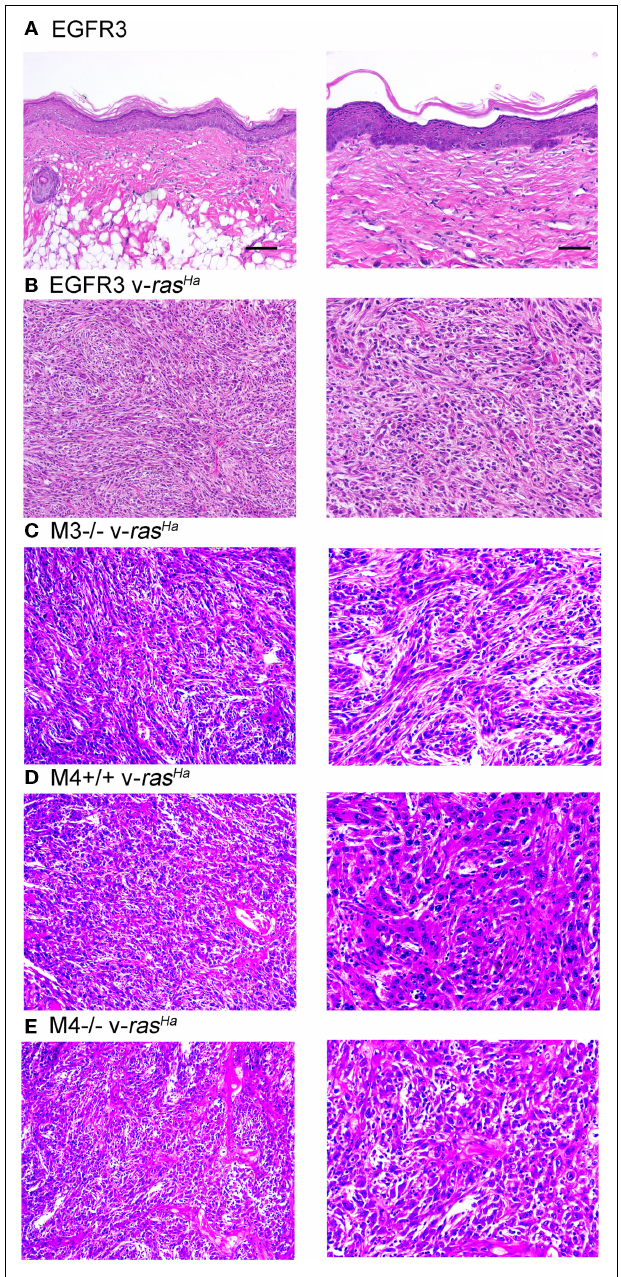
FIGURE 6 | Non-transformed immortalized keratinocytes produce epidermis in orthotopic skin grafts or squamous cell carcinoma following introduction of a v- ras Ha oncogene . Immortalized EGFR3 line keratinocytes from an Egfr fl/fl mouse on an FVB/N background ( N = 3) (A) , EGFR3 keratinocytes infected with a v- ras Ha -expressing retrovirus (B) , immortalized M3 (cid:0) / (cid:0) keratinocytes from an Egfr (cid:0) / (cid:0) CD-1 mouse infected with a v- ras Ha -expressing retrovirus ( N = 6) (C) , immortalized M4 + / + keratinocytes from a CD-1 mouse infected with a v- ras Ha -expressing retrovirus ( N = 6) (D) , or immortalized M4 (cid:0) / (cid:0) Egfr (cid:0) / (cid:0) keratinocytes from an Egfr (cid:0) / (cid:0) CD-1 mouse infected with a v- ras Ha -expressing retrovirus ( N = 2) (E) were mixed with primary dermal fibroblasts and grafted onto the backs of athymic nude mice. Grafts were removed after 6months, fixed, sectioned, and stained with hematoxylin and eosin. Images are representative of multiple grafts obtained for each group. Scale bars indicate 50 μ m (left) or 100 μ m